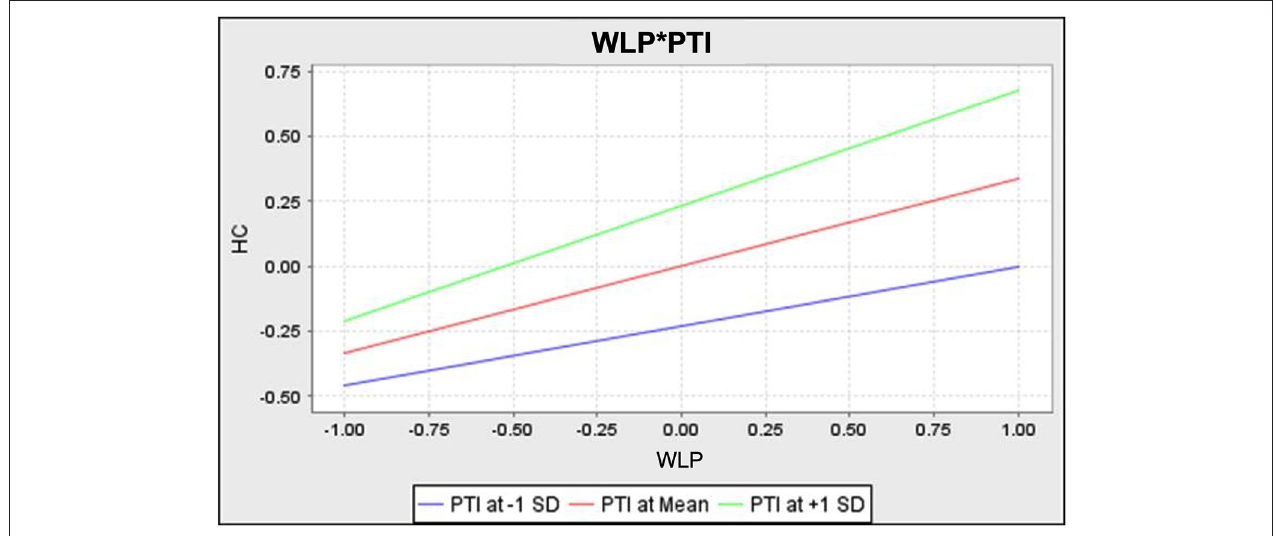
FIGURE 2 | Interaction plot of WLP*PTI on hesitation at